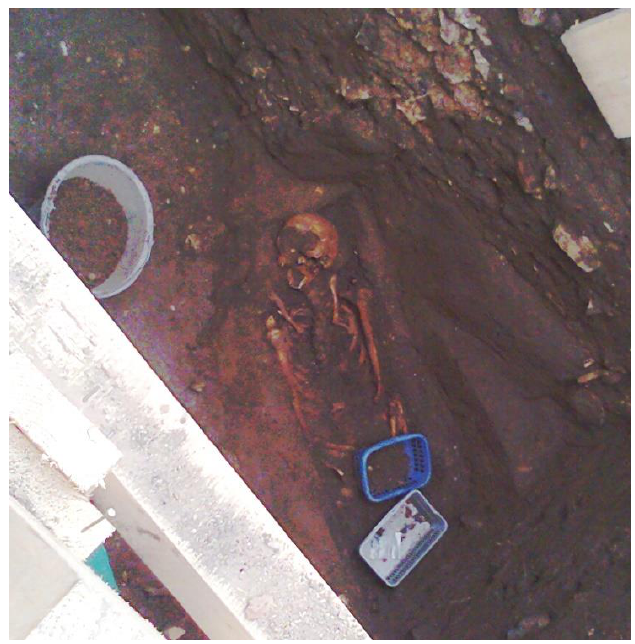
Figure 18. Charles Square. Grave with skeleton which was detected by ERT.